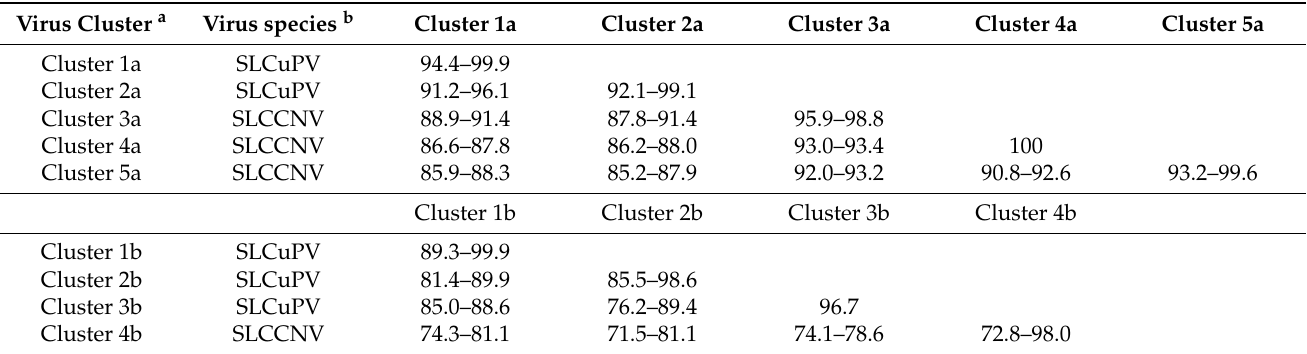
Table 2. Nucleotide sequence identity (%) among DNA sequences of cucurbit-infecting bego- moviruses in the